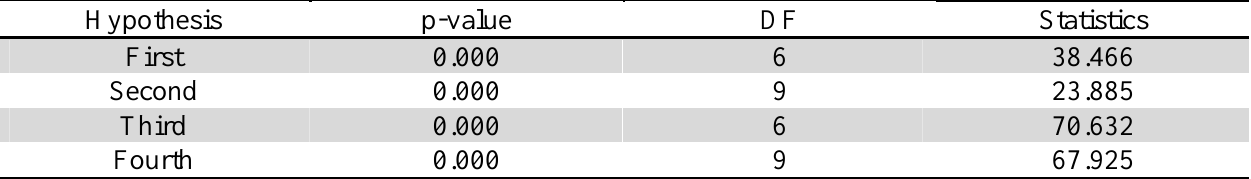
The summary of Chi-Square